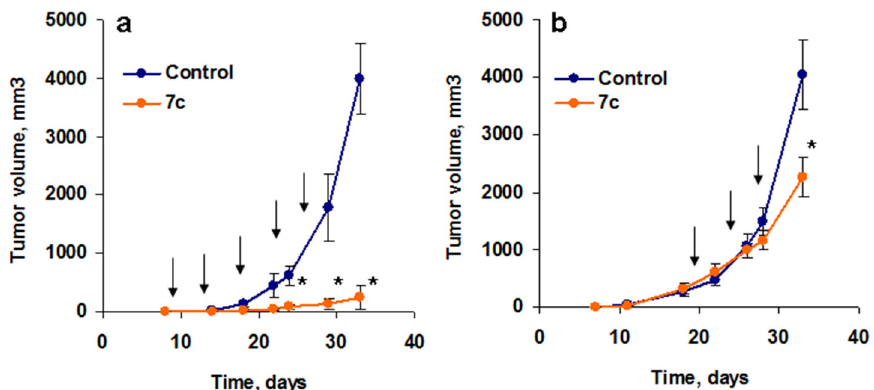
Figure 10. Effect of compound 7c on tumor growth. ( a , b ) BALB/c mice were s.c. inoculated with colorectal Colon ‐ 26 cells. Tumor growth in control and at early ( a ) or late ( b ) treatment with compound 7c . Dates of the treatment with 7c are shown with arrows, significant differences—with asterisks ( p < 0.05). Data are shown as average ± SEM.